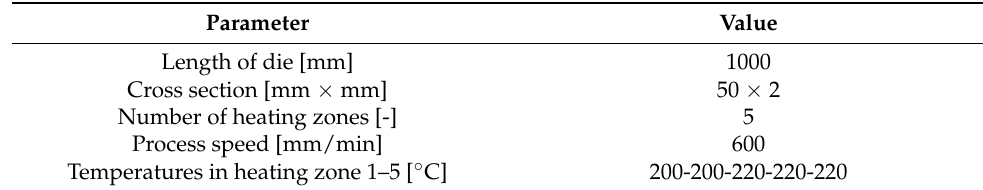
Figure 2. Pultrusion line setup: ( a ) CF inlet; ( b ) pultruded CFRP profile. Table 2. Process parameters.